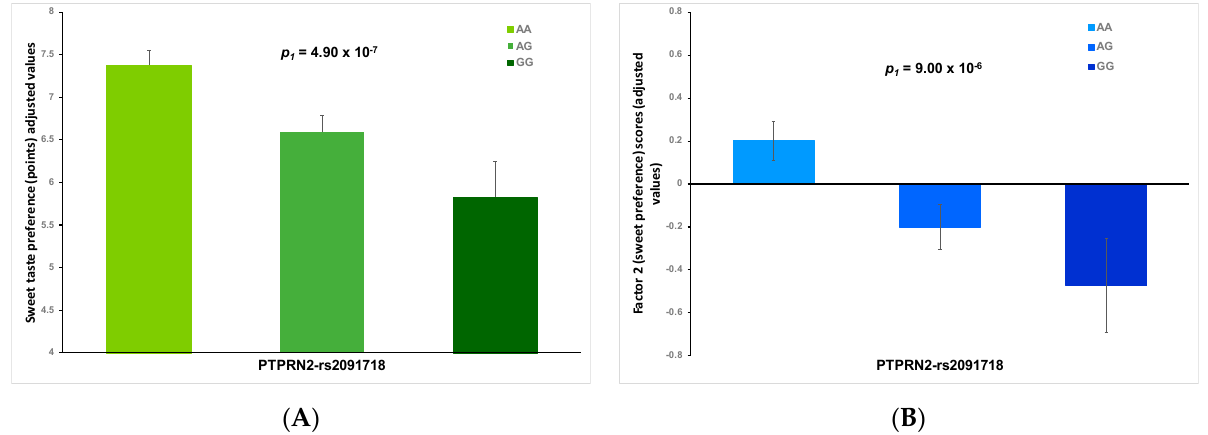
Figure 6. Adjusted means for sweet taste preference (Panel ( A ): using the sweet taste preference variable as continuous; and Panel ( B ): using the factor 2 scores) depending on the lead SNP rs2091718, located in the protein tyrosine phosphatase receptor type N2 (PTPRN2) gene in the whole population. Adjusted means and p -values ( p 1 ) have been obtained in a general linear regression model adjusted for sex, age, type 2 diabetes, BMI, smoking, physical activity, hours of sleep per night and adherence to Mediterranean diet. Minor allele frequency (MAF) is 0.24 for the G allele in this population. Genotype prevalence: AA (58.1%); AG (38.8%); and GG (5.1%).